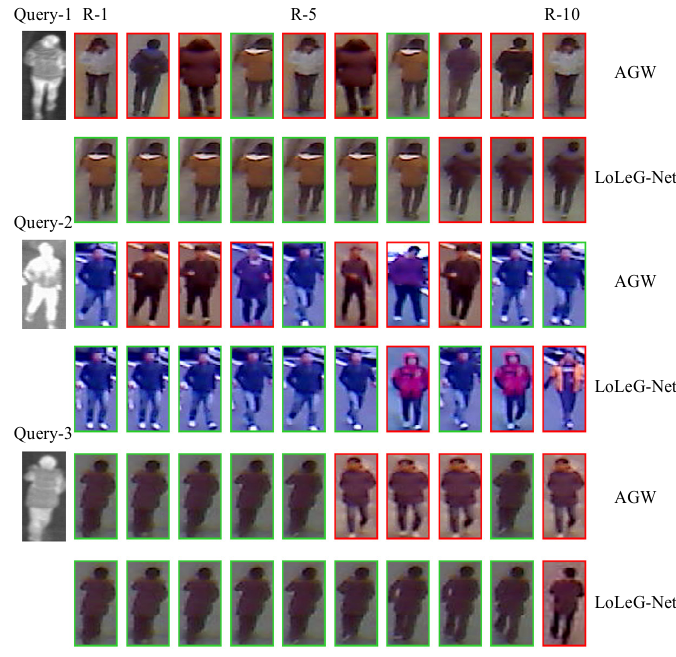
Figure 6. Visual recognition performance of AGW with LoLeG-Net for RegDB in I2V mode.